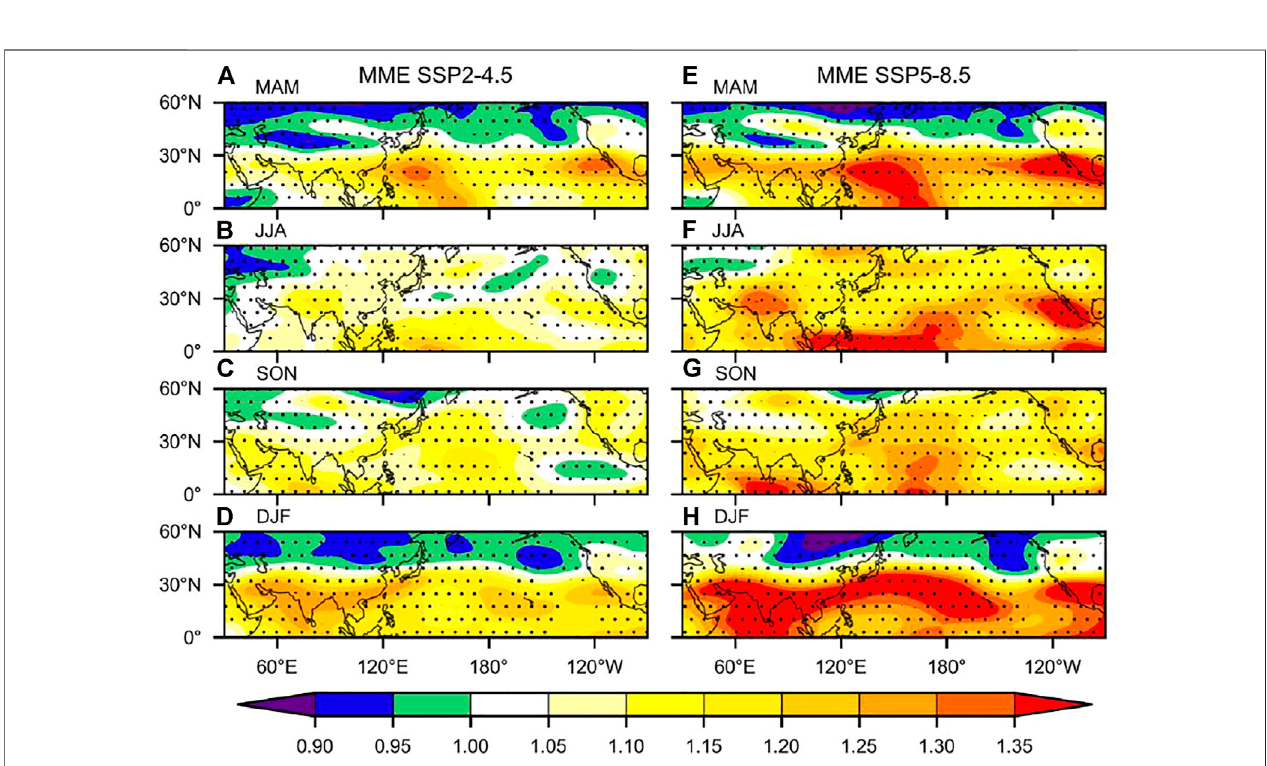
FIGURE 10 | Ratio of MME projected UTT standard deviation during 2050 – 2099 under (A – D) SSP2-4.5 and (E – H) SSP5-8.5 to that during 1965 – 2014 in (A,E) spring, (B,F) summer, (C,G) autumn and (D,H) winter. Regions above the 95% signi fi cance level are dotted.